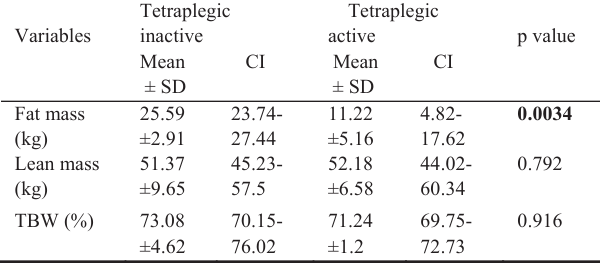
Table 3: BIA results comparing tetraplegic groups (active X inactive).